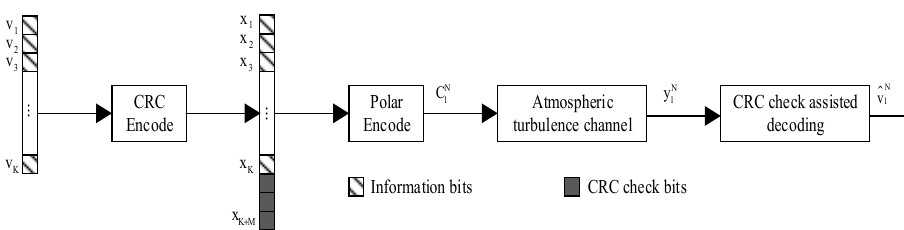
Figure 2. Coding and decoding flow chart of cascaded CRC polar code.